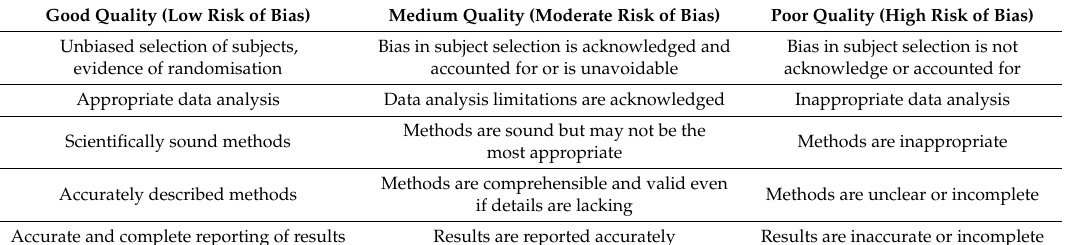
Table 2. Quality criteria tool used to assess the level of bias in studies selected for inclusion in the review. Adapted from